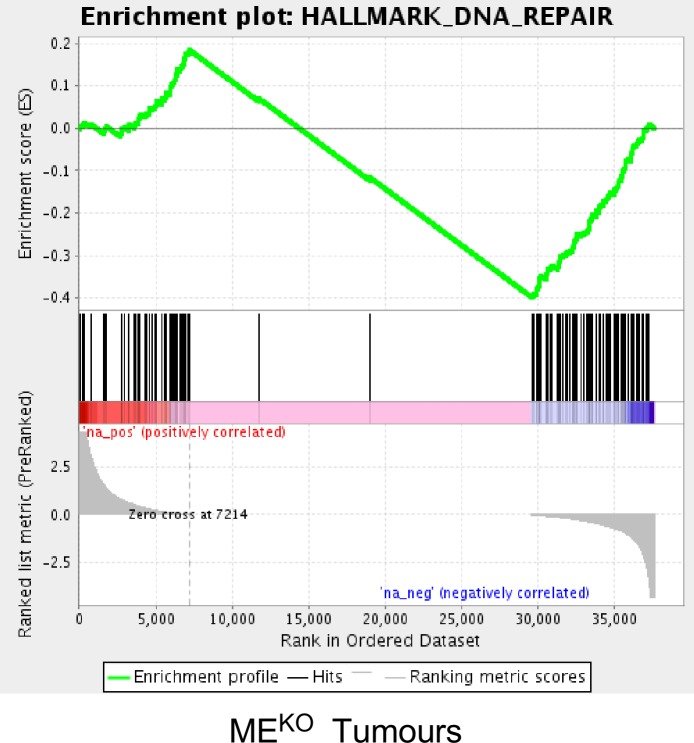
Gene set enrichment analysis demonstrates that JNK deficiency causes decreased expression of a ‘DNA Repair’ gene signature.GSEA plot of a ‘DNA Repair’ gene signature by MEKO tumor cells compared with primary mammary epithelial cells (MEC) (p<0.01).